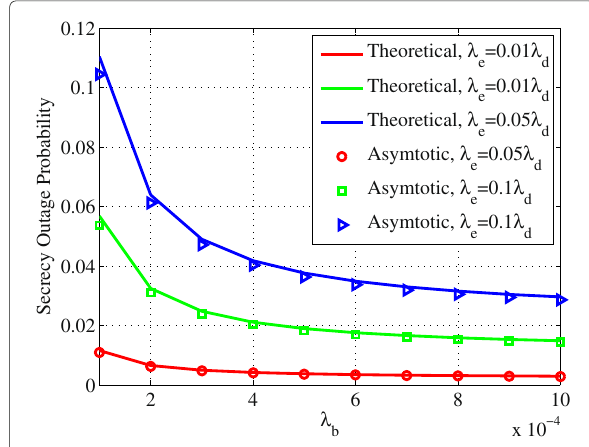
Fig. 2 The secrecy outage probability of the typical cellular link versus the density of the base station λ b under different densities of the eavesdropper λ e in scenario I where λ d = 0.001 / m 2 , φ = 0.6. Figure 2